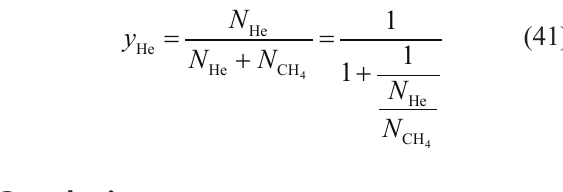
Fig. 10 – Impact of He mole fraction in feed stream on He membrane flux